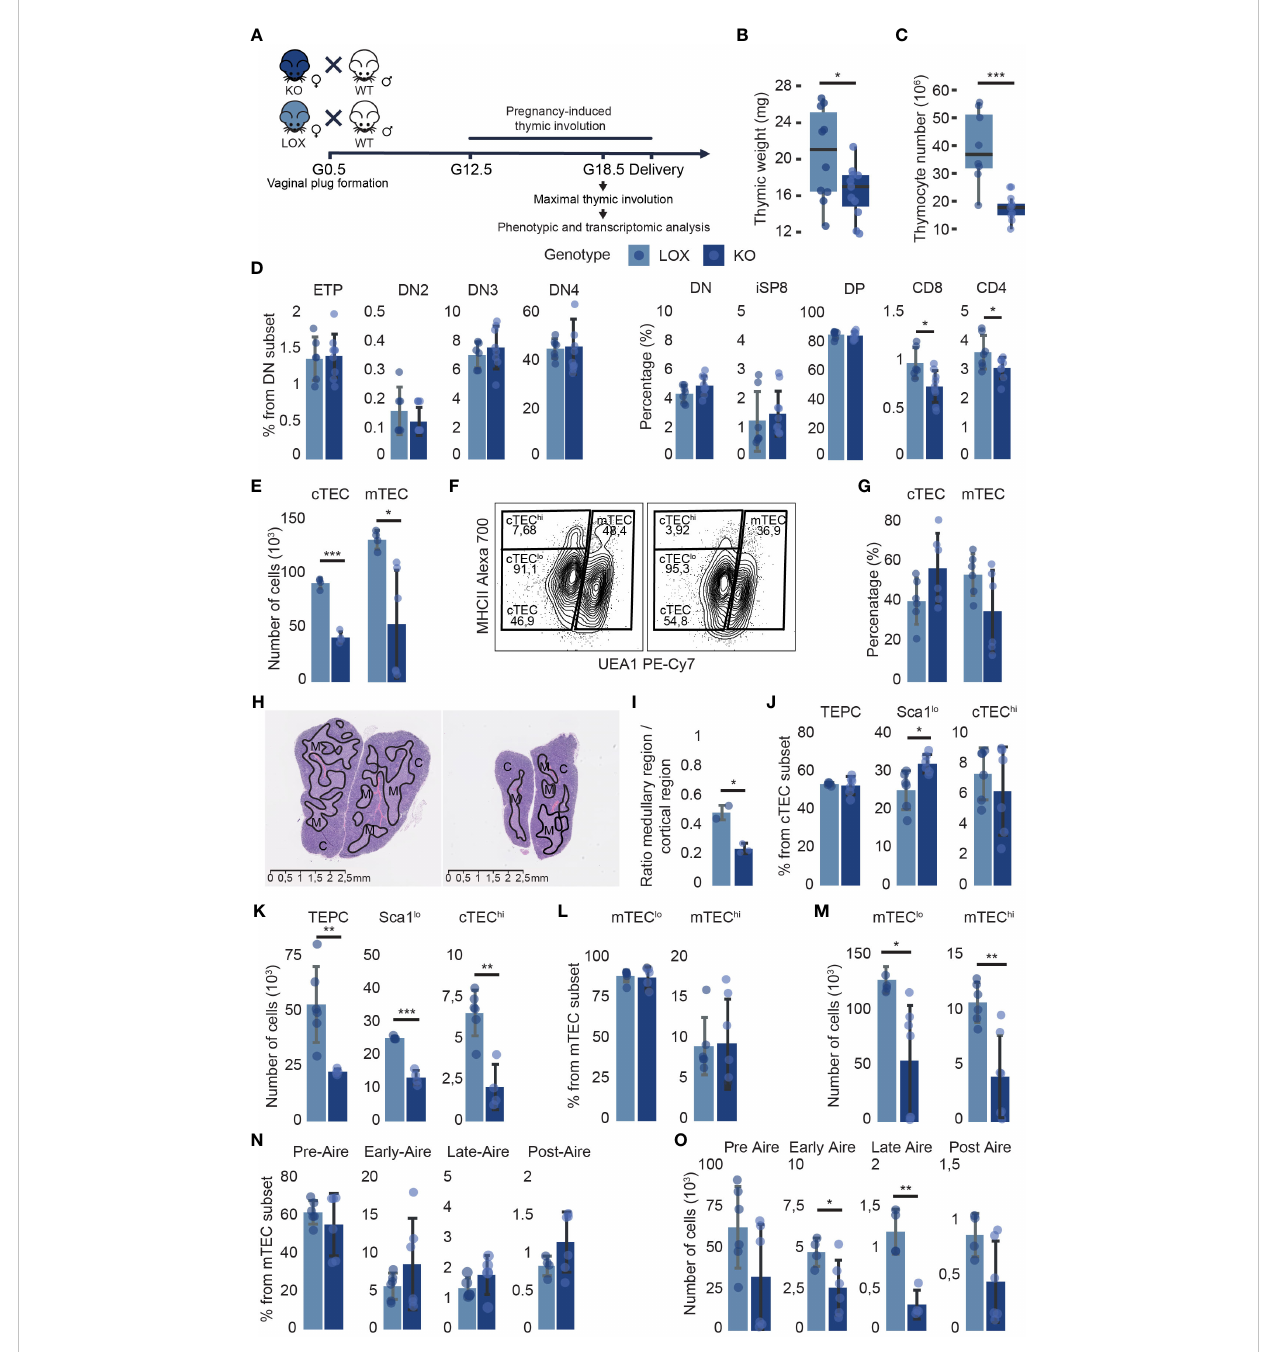
FIGURE 5 Klf4 deletion in TECs alters thymus composition during pregnancy-induced thymic involution. (A) Experimental design to analyze the impact of Klf4 deletion during late pregnancy. G0.5, G12.5, G18.5, gestational stages. (B, C) Thymic weight (mg) (from n=18-22 mice per genotype, tested in fi ve independent experiments) (B) , and thymocyte number (n=8-10) (C) of pregnant LOX and KO females. Results are expressed as the median and IQR. (D) Proportions of thymocyte subsets in pregnant LOX and KO females (n=6-10 per group). (E) cTEC and mTEC numbers in pregnant LOX and KO females (n=4-6 per group). (F) Contour plots from fl ow cytometry analysis representing global cTEC and mTEC gates, and cTEC hi and cTEC lo gates within EpCAM + CD45 - subsets in LOX (left) and KO (right) females. (G) cTEC and mTEC proportions of LOX and KO females (n=6). (H) H&E staining of thymus from pregnant LOX (left) and KO (right) females. Solid black lines delineate cortical (C) and medullary (M) regions. (I) Relative surface area of the medullary region compared to the cortical region per lobe of pregnant LOX and KO females. (J, K) cTEC subpopulation proportions (J) and absolute numbers (K) in pregnant LOX and KO females (n=4-6). (L, M) mTEC lo and mTEC hi percentages (L) and numbers (M) in KO and LOX females (n=3-5). (N, O) mTEC subpopulation proportions (N) and absolute numbers (O) in pregnant LOX and KO females (n=4-6). All analyses were performed on the thymi of pregnant females. TECs and thymocytes were analyzed in two and three independent experiments, respectively. LOX and KO genotypes are displayed in pale blue and dark blue, respectively. Signi fi cance was assessed using an unpaired two-tailed Student ’ s t -test. (* p <0.05, ** p >0.01 and *** p